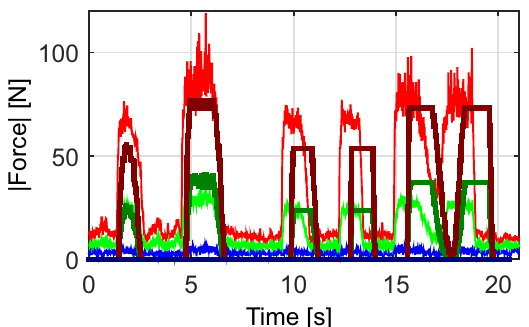
Figure 10. Comparison of the measured and the sim- ulated force signal in the case of down- and upmilling. Measured forces: (cid:4) - maximum, (cid:4) - average, (cid:4) - min- imum; Calculated forces: (cid:4) - maximum, (cid:4) - average, (cid:4) - minimum.